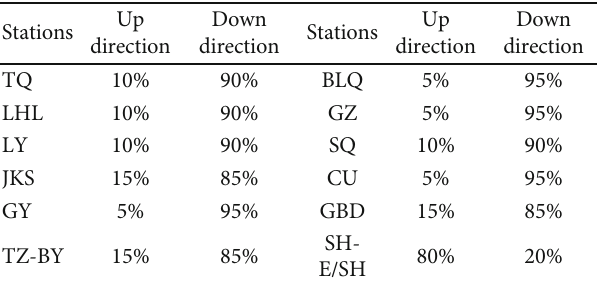
Table 3: The percentage of the acreage assigned to the passengers on each direction of all